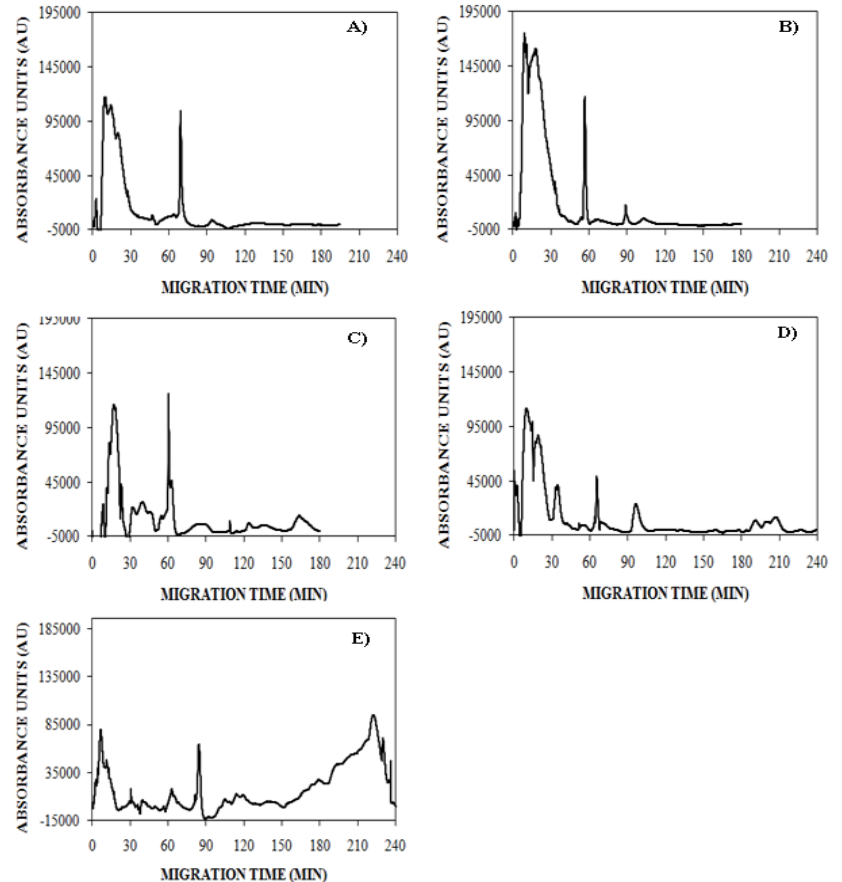
Figure 1. Detection of insulin monomer, oligomer, and higher molecular weight aggregation states using UV-CE. Insulin was aggregated under agitation (185 rpm) at 0.2 mg/mL in 40 mM Tris (pH 8.0) containing 150 mM NaCl and at 25 ° C. At 0 h (panel A ), 4 h (panel B ), 8 h (panel C ), 12 h (panel D ), and 24 h (panel E ), CE was performed in conjunction with UV detection with a 0.5 psi pressure injection for 8 s with separation at 15 kV using 0.5% PHEA separation matrix in a PHEA coated capillary. Results are representative of three independent experiments. Supplementary data confirms the absence of significant peaks at a migration time of >180 min for 0, 4, and 8 h time